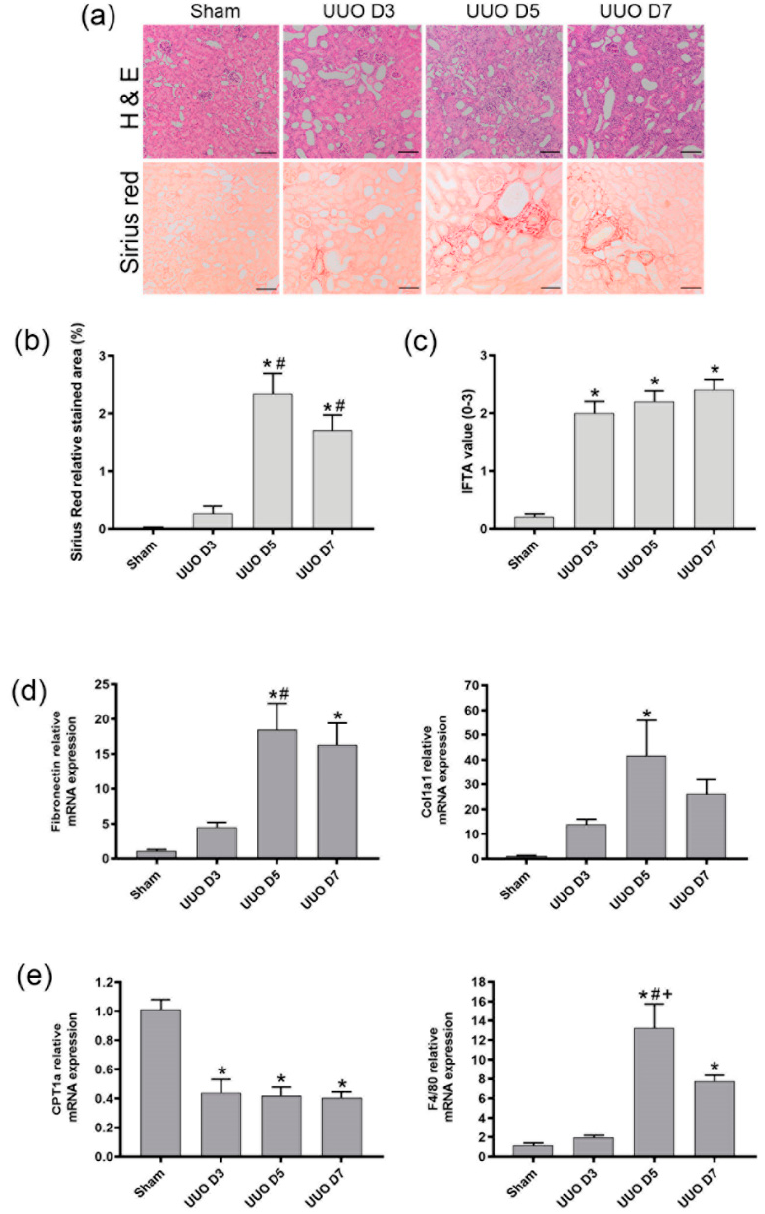
Figure 1. Fibrosis evolution analysis in Unilateral Ureteral Obstruction mice. CD1 mice underwent UUO surgery and kidneys were harvested on days 3, 5 and 7 after surgery. Sham operated mice were used as control. ( a ) Representative images of hematoxylin and eosin (H&E) and Sirius red of kidney sections; objective magnification × 100, scale bar 100 µ m. ( b ) Graphical quantification of Sirius red represented as relative stained area (%) and ( c ) H&E using Banff criteria. ( d – e ) mRNA levels of ( d ) Fibronectin and Col1a1 and ( e ) F4/80 and CPT1a assessed by qPCR. Levels of mRNA were normalized to those of GAPDH and expressed as fold change. Data presented as mean ± SEM; n = 5 per group from 3 independent experiments; * p < 0.05 vs. sham. # p < 0.05 vs. UUO day 3. + p < 0.05 vs. UUO day 7.